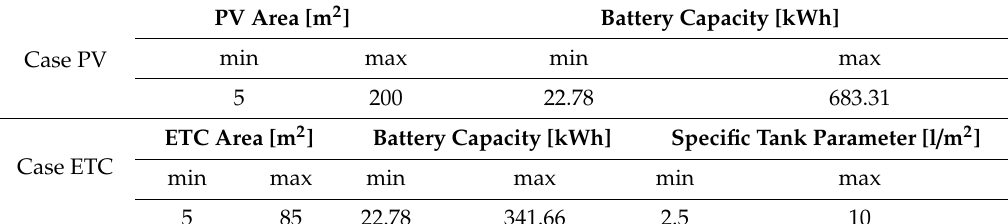
Table 9. Parameter varied during the optimization analysis, PV layout and ETC playout.